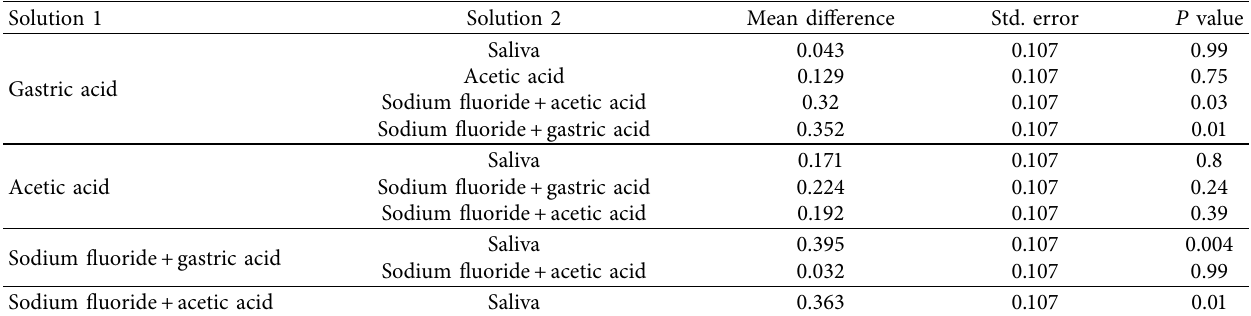
Table 4: Pairwise comparisons of different solutions regarding the changes in Rq after immersion using Tukey’s test. Solution 1